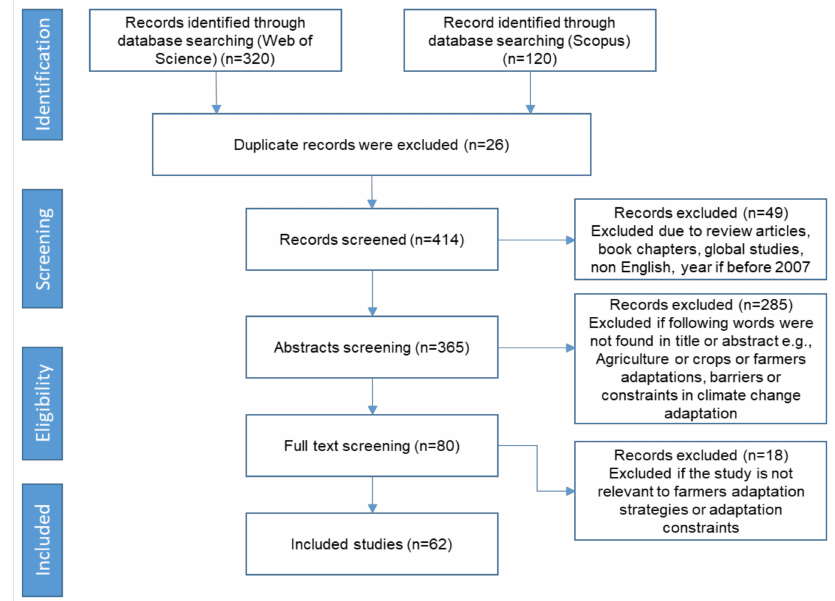
Figure 1. Systematic review